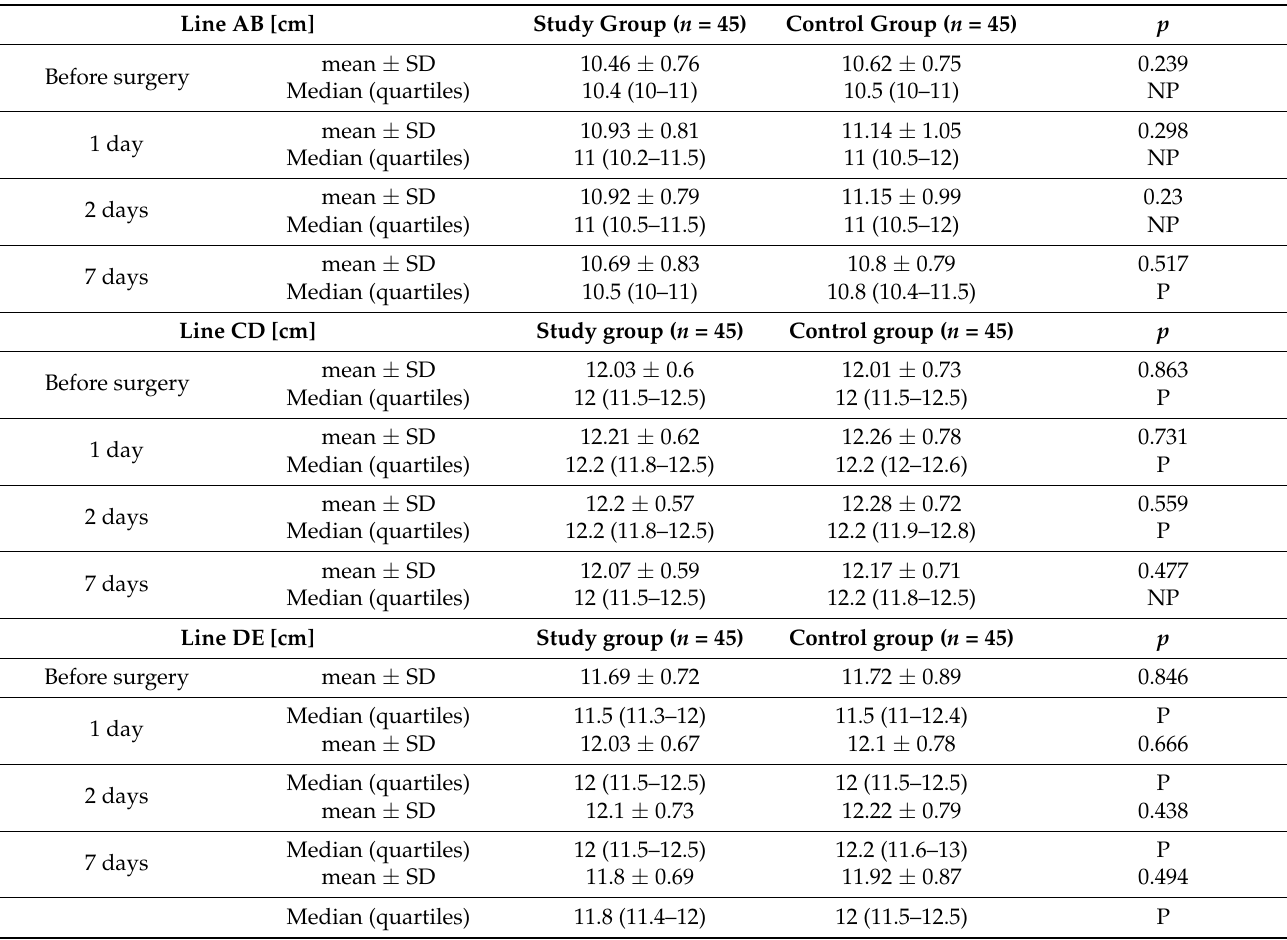
Table 6. AB, CD and DE line length measured before surgery and on postoperative Days 1, 2, and 7 between the study group and the control